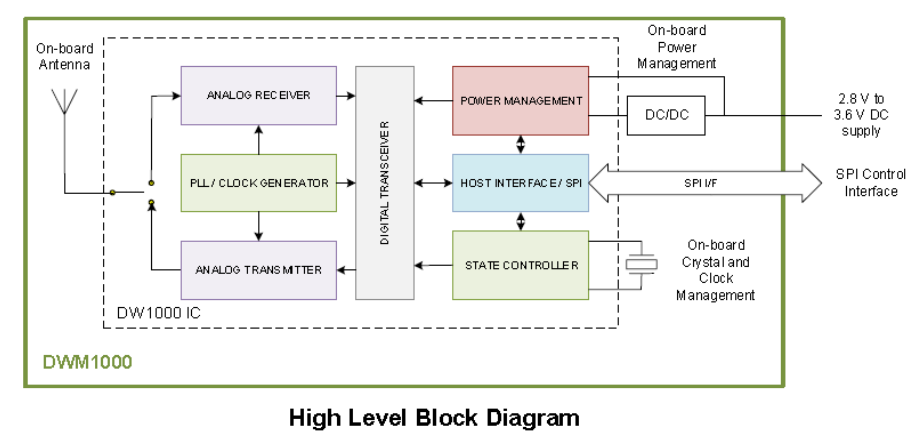
Figure 4. Decawave Sensor DWM1000: Block